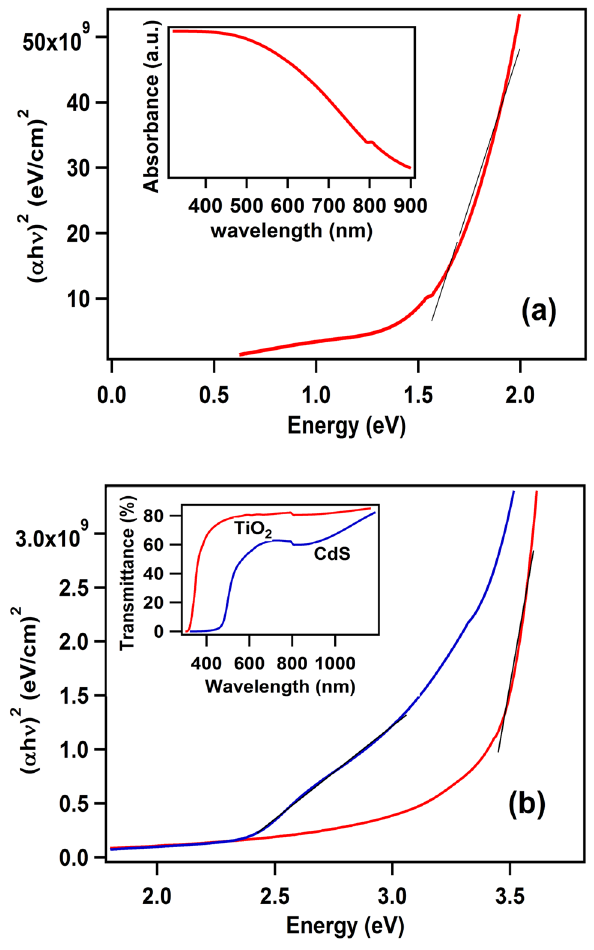
Fig. 4 a Tauc plot and absorbance spectrum (inset) of CZTS film deposited on glass. b Tauc plots and transittance spectrum (inset) of CdS and c-TiO 2 films deposited on glass substrates